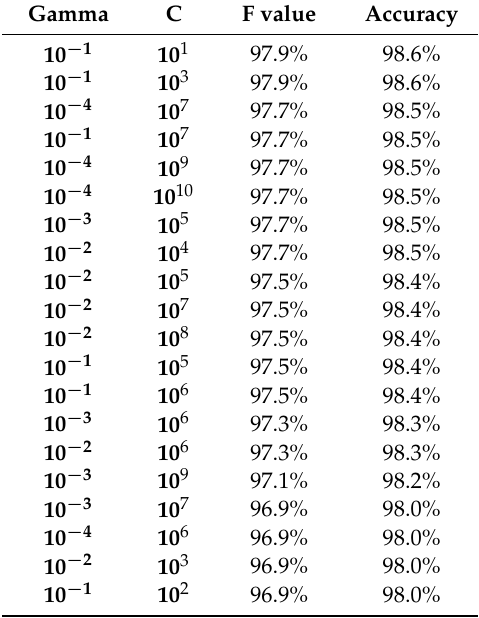
Table 3. Metrics of Different Parameter Combination Models for the Validation Set.